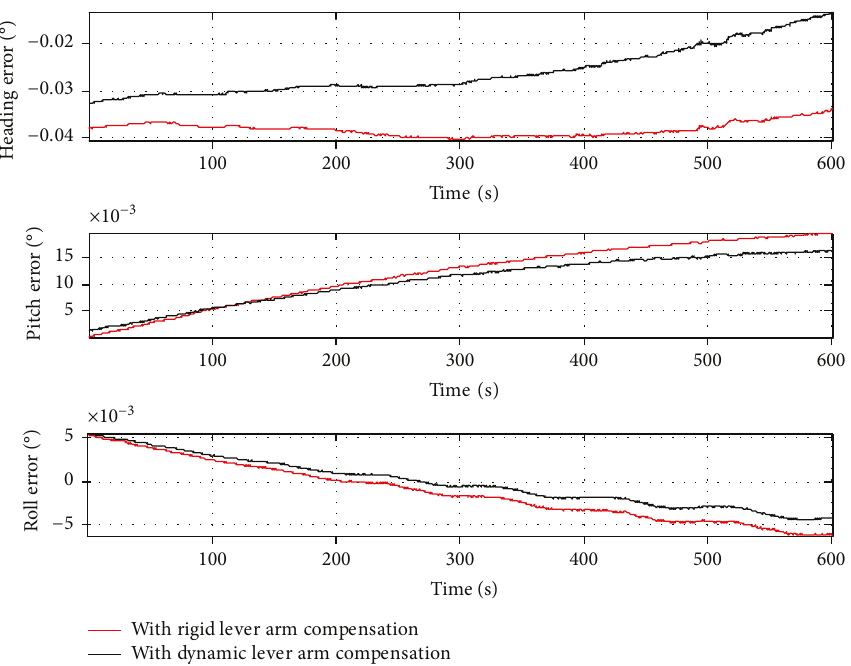
Figure 9: Attitude error comparison of the fi rst-level dynamic lever arm error